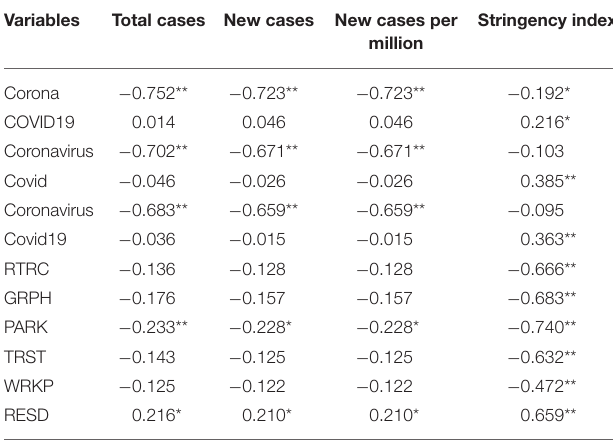
TABLE 1 | Correlation analysis results testing the association between restlessness, mobility, and COVID-19 case numbers.